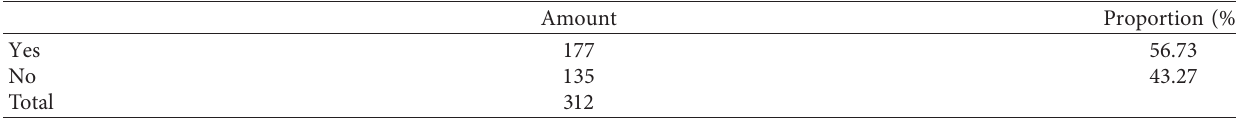
Table 4: Distribution of the respondents’ marital